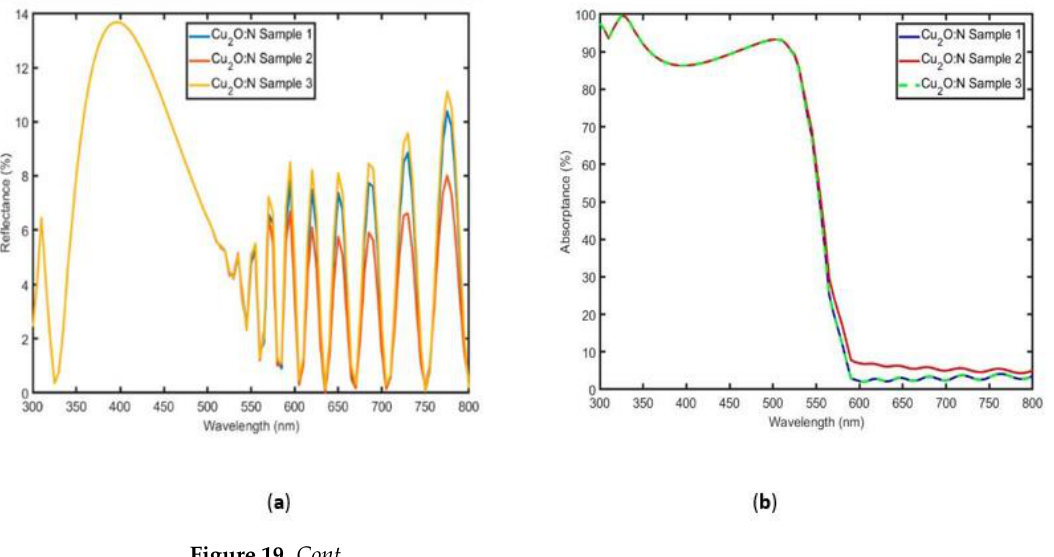
Figure 19. ( a ) Reflectance, ( b ) absorbance, and ( c ) transmittance as a function of wavelength for the metal oxide structure [100].